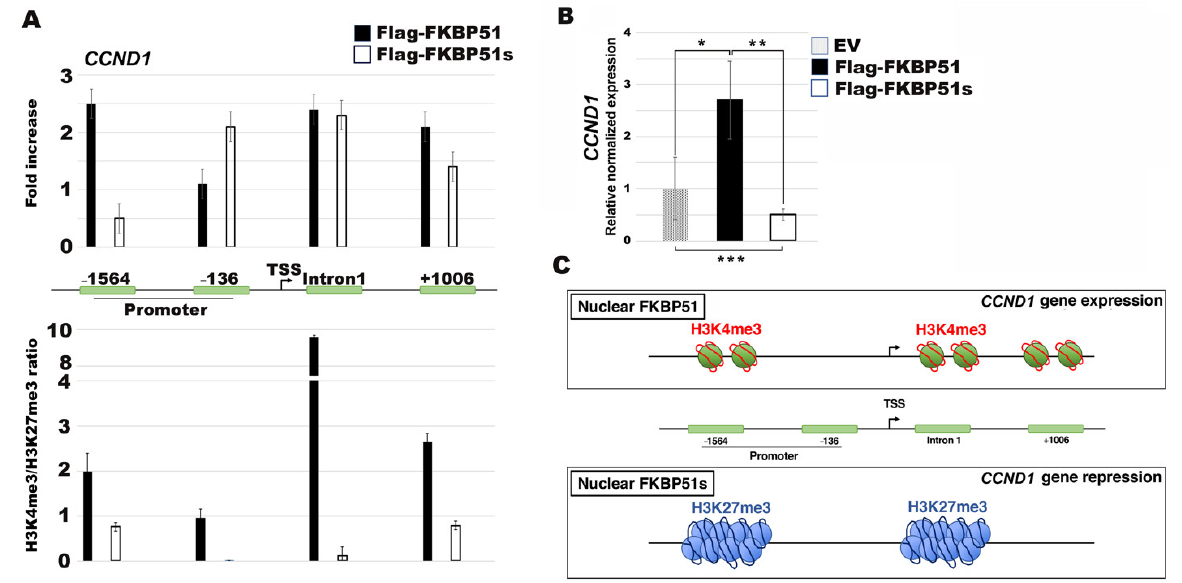
Figure 4. FKBP51 isoforms occupancy on the CCND1 promoter. ( A ) Upper panel, xChIp assay performed with an anti-Flag antibody (upper panel) and with anti-H3K4me3 and anti-H3K27me3 (lower panel) in shFKBP51.3 A375 cells overexpressing Flag-FKBP51 or Flag-FKBP51s. After 24 h from transfection, qPCR analysis was performed using primers covering the 4 represented regions of the CCND1 gene (−1564 and −136 in the promoter and intron 1 and +1006 in the intronic sequences following the TSS). ( B ) QPCR analysis of CCND1 mRNA expression in shFKBP51.3 A375 cells, transfected with empty vector (EV, grey) or the FKBP51 isoforms (Flag-FKBP51, black; or Flag-FKBP51s, white). (EV = control sample, expression = 1). Data are mean ± SD (N = 4). * p = 0.014, ** p = 0.01, *** p = 0.032. ( C ) Schematic representation of the chromatin status on the CCND1 gene in cells overexpressing FKBP51 or FKBP51s.